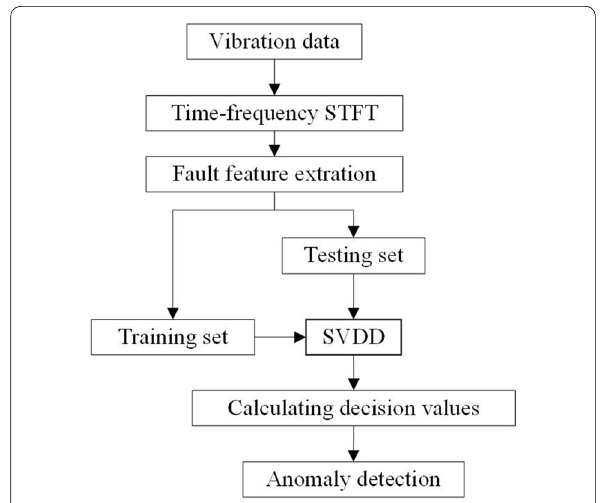
Figure 15 Fault detection scheme of He et al.